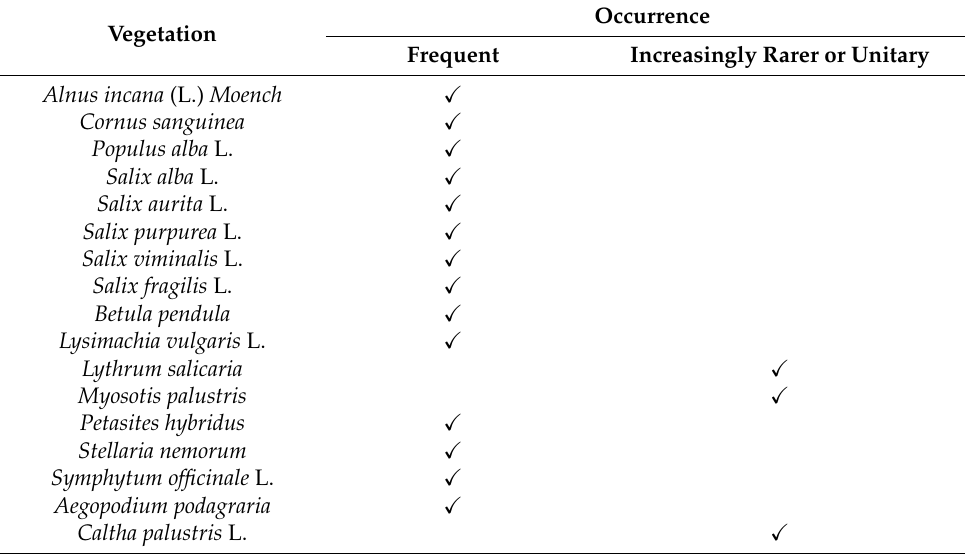
Table 3. Plant species occurring in the area of the Vistula valley in its upper course. Vegetation